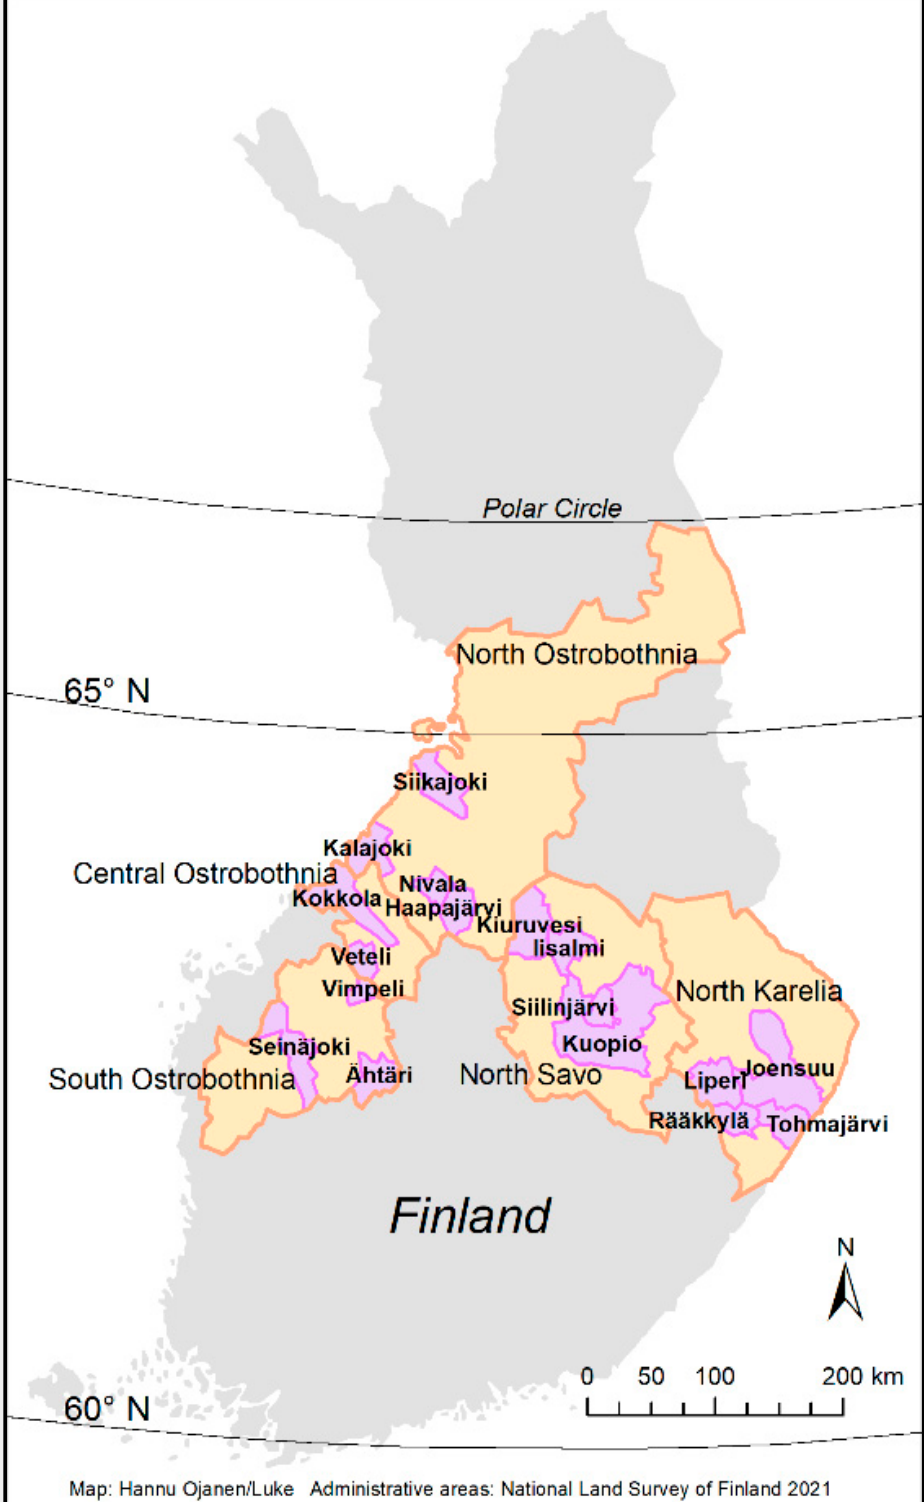
Figure 1. Location of farms in Finland where silage samples were collected in 2020. Yellow areas represent regions and purple areas represent municipalities where the farms were located.